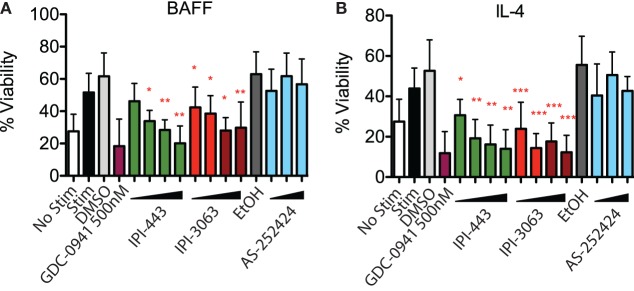
IPI-3063 potently inhibits mouse B cell survival. Total splenocytes were pretreated with inhibitors as indicated, then cultured with 10 ng/mL IL-4 (A) or 60 ng/mL of BAFF (B) for 48 h. Concentrations used were 1 nM, 10 nM, 100 nM, 1 µM for IPI-443 and 1, 10, 30, 100 nM for IPI-3063. AS252424 concentrations were 100 nM, 300 nM, and 1 µM, and GDC-0941 was at 500 nM. % viability was calculated by measuring % of B220+7AAD− cells. Samples were collected by time. (*P < 0.05, **P < 0.001, ***P < 0.0001 one-way ANOVA with Newman–Keuls multiple comparison test).